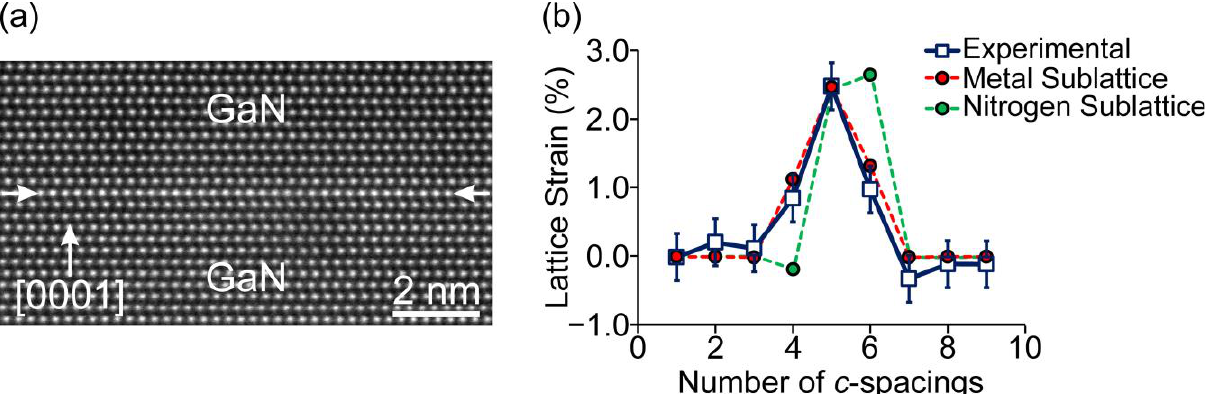
Figure 6. ( a ) HRSTEM image of 1 ML In x Ga 1− x N/GaN quantum well with indium content close to 30%. ( b ) Profiles of lattice strain e zz along [0001]. Experimental profile, obtained from ( a ) by peak